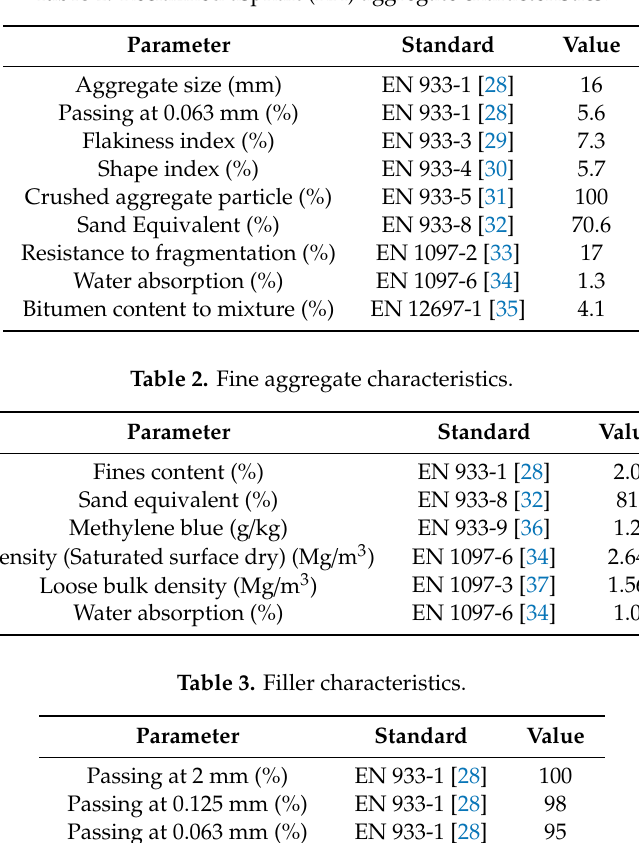
Table 1. Reclaimed asphalt (RA) aggregate characteristics.